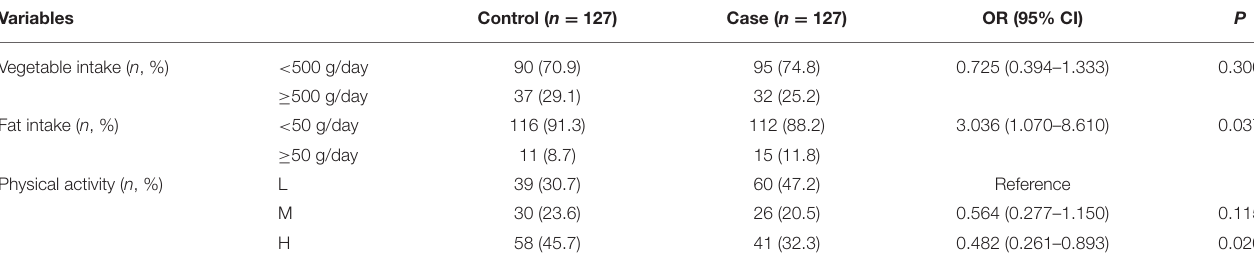
TABLE 5 | Environmental risk assessment for T2DM in couple case-control study. Variables Control ( n =